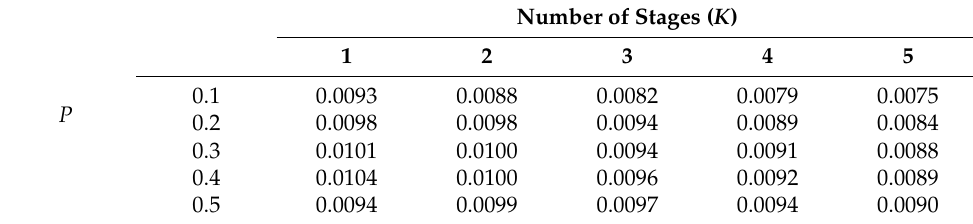
Table 4. Type I values resulted from Monte Carlo simulations for α = 0.01 with the